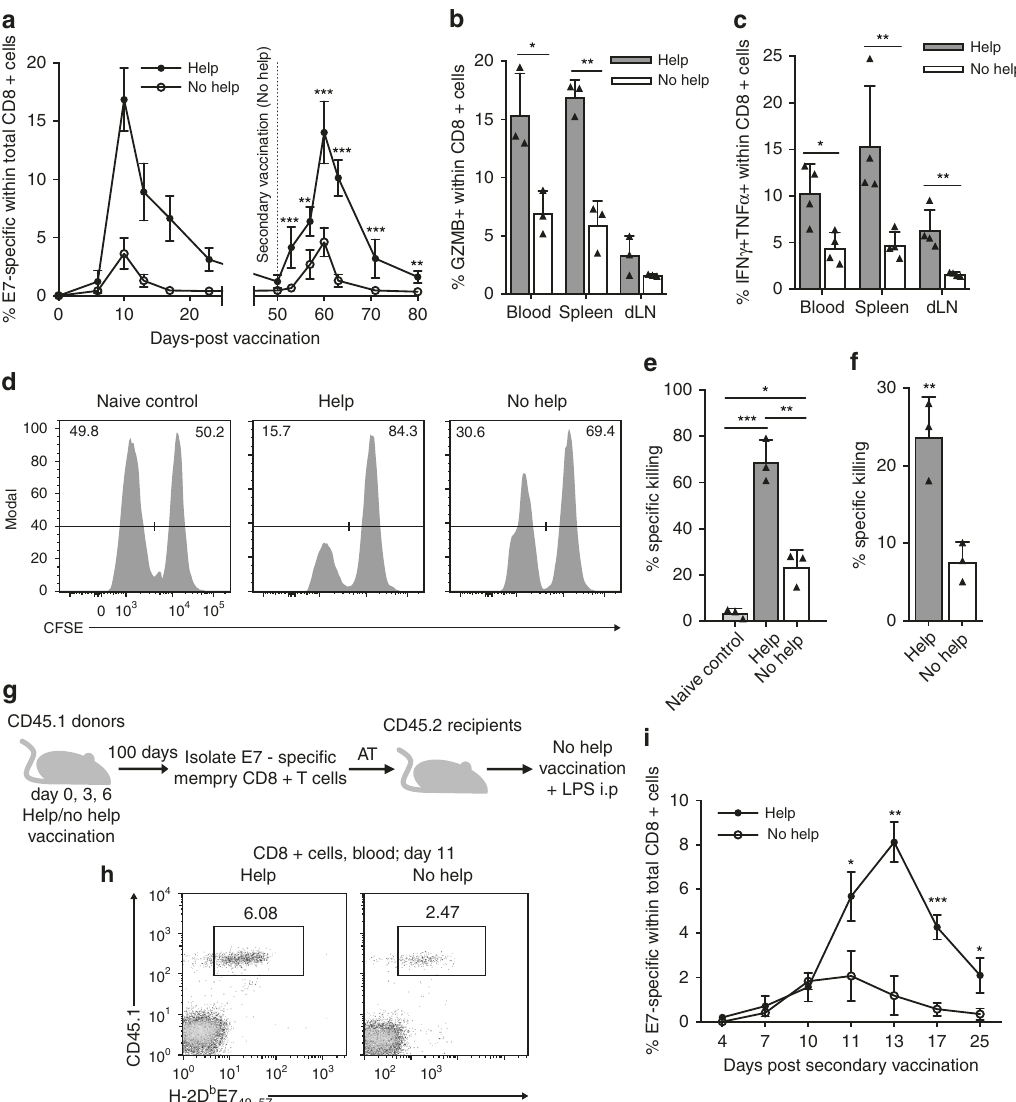
Fig. 1 CD4 + T cell help instills intrinsic recall capacities into CD8 + T cells. a – f Mice were vaccinated intra-epidermally with a DNA construct encoding HPV-E7 with (Help) or without (No Help) MHC class II-restricted epitopes on days 0, 3, and 6. On day 50, mice were rechallenged with No Help vaccine and i.p. lipopolysaccharide (LPS) injection. (A) Percentage of H-2D b /E7 49-57 tetramer + cells among total CD8 + T cells in blood at indicated days after fi rst vaccination ( n = 7 per group). b , c In a separate experiment, on day 10 after rechallenge, frequencies of Granzyme B (GZMB) + cells (B) and IFN γ + TNF α + cells (C) within total CD8 + T cells in indicated tissues were determined by fl ow cytometry ( n = 3 – 4). d , e In a separate experiment, mice ( n = 3) were injected i.v on day 10 after rechallenge with a 1:1 ratio of splenocytes loaded with E7 49-57 peptide (CTL target) or not (control) and labeled with a low or high dose of carboxy fl uorescein succinimidyl ester (CFSE), respectively. Naive recipient mice were used as control. After 15 h, percentage of speci fi c in vivo target cell killing was determined by fl ow cytometric analysis of splenocytes. d Representative histograms of CFSE + cells. e Bar diagram quantitatively depicting all results. f In a separate experiment, E7-speci fi c CD8 + T cells were isolated from spleen at day 10 after rechallenge ( n = 3). T cells were incubated in vitro at a 1:1 ratio with E7 49-57 -peptide-loaded or non-loaded splenocytes and speci fi c killing of target cells was analyzed 12 h later. g – i CD45.1 + donor mice received Help or No Help vaccine. At day 100, E7-speci fi c (memory) CD8 + T cells were isolated from spleens and injected i.v. in equal numbers into CD45.2 + recipient mice ( n = 4 per group). One day later, recipient mice were rechallenged. g Experimental set up. h Representative fl ow cytometry plots indicating frequencies of CD45.1 + E7-speci fi c CD8 + T cells in blood at day 11 after rechallenge. i Frequencies of CD45.1 + E7-speci fi c CD8 + T cells in blood at indicated days after vaccination. Data in this fi gure are from one experiment representative of at least two experiments. Error bars indicate SD, * p < 0.05, ** p < 0.01, *** p < 0.001 (unpaired two-tailed Student ’ s t test). Source data are provided as a Source Data fi